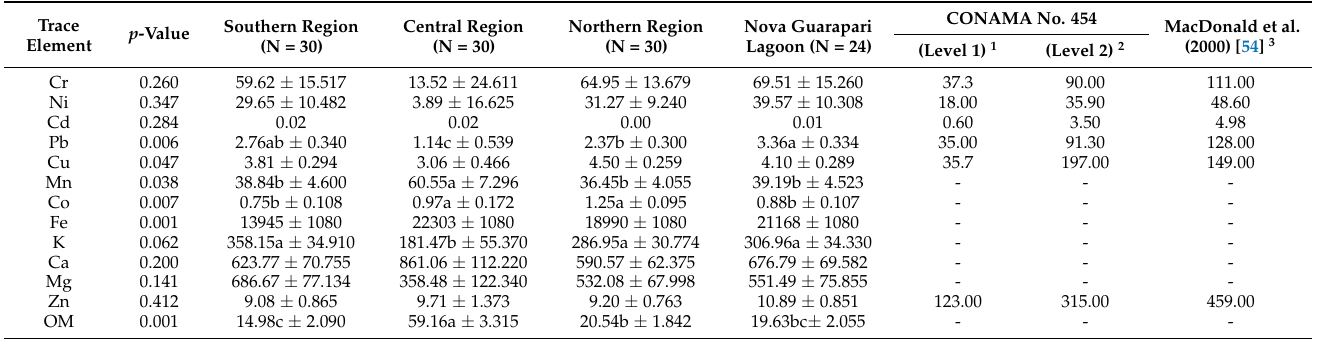
Table 3. Mean and standard deviation of trace element concentrations (mg kg − 1 ± SD of dry weight) in the southern, central, and northern regions of the M ã e-B á and Nova Guarapari (reference) Lagoons and the percentage of organic matter (OM) in the sediment.